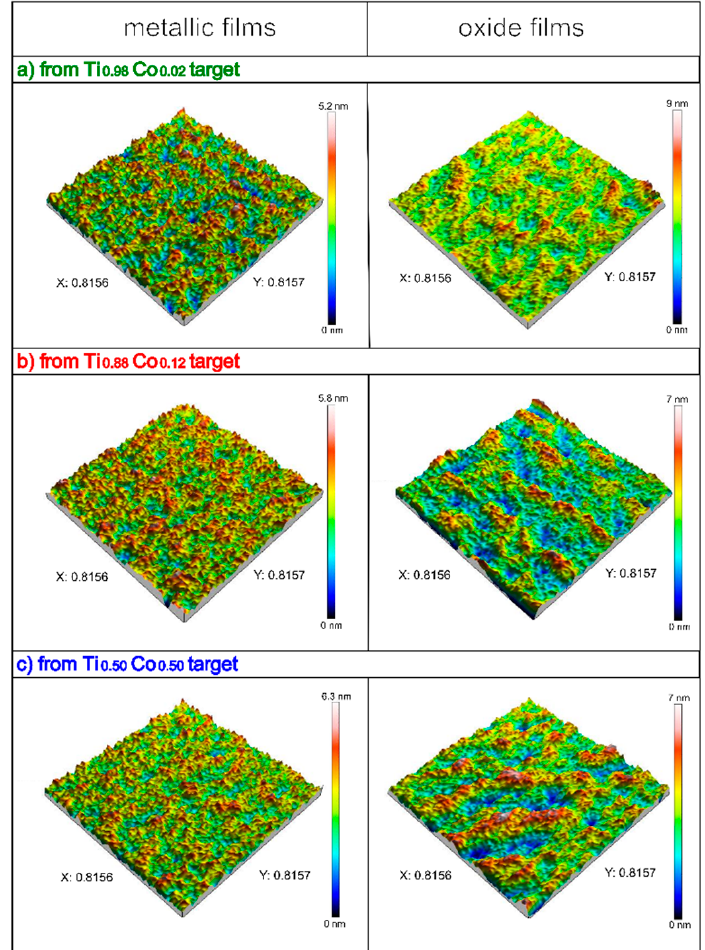
Figure 4. Three-dimensional profiles of metallic Ti–Co and oxide (Ti,Co)Ox thin films prepared by magnetron sputtering from different targets.